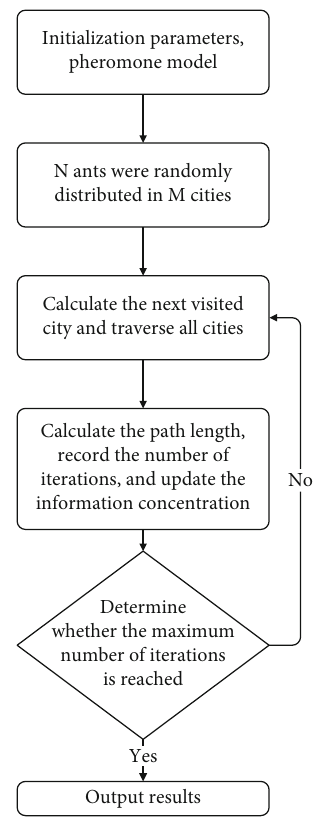
Figure 13: Basic fl ow diagram of ant colony